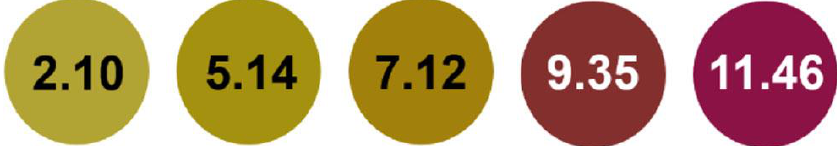
Figure 4. Colors of the curcumin-cellophane sensors after exposure to standard pH solutions (Radelkis Kft., Budapest, Hungary; pH 2.10, 5.14, 7.12, 9.35, and 11.46 (±0.03 at 25°C)) [75].